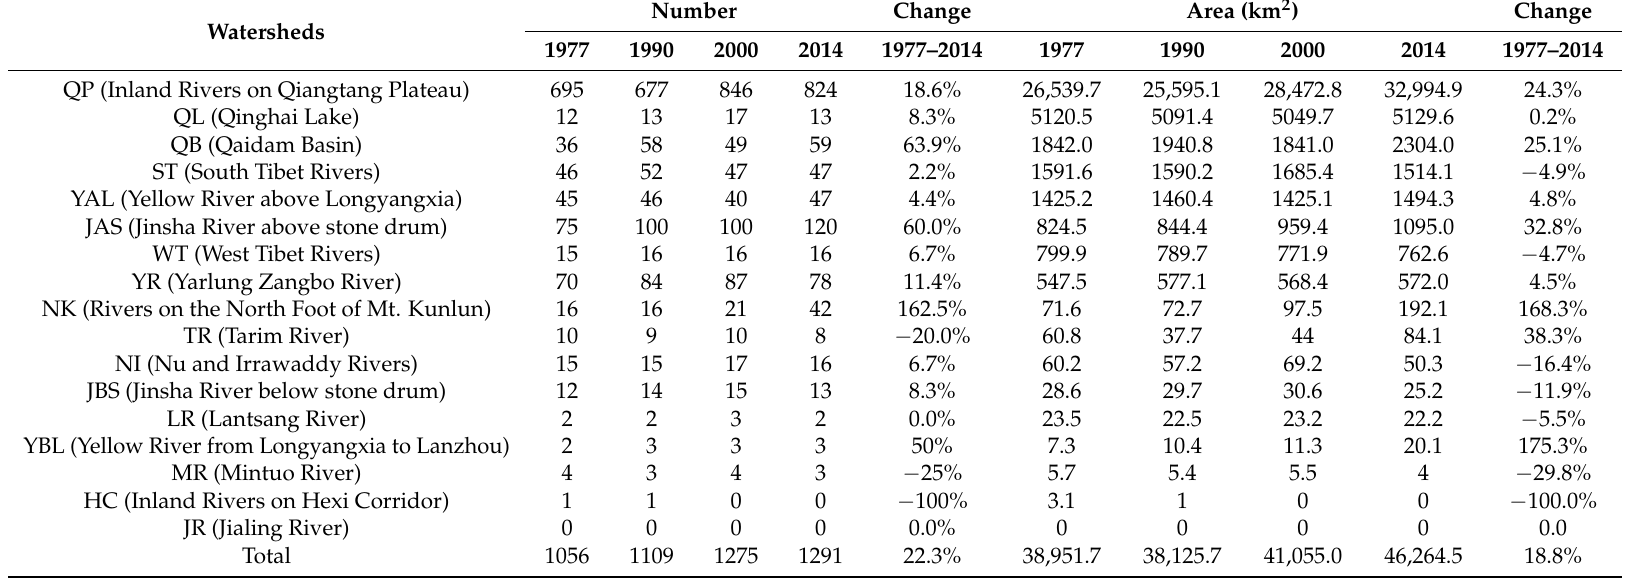
Table 1. Lake number, area (km 2 ), and their changes in different watersheds of the Tibetan Plateau between 1977 and 2014.